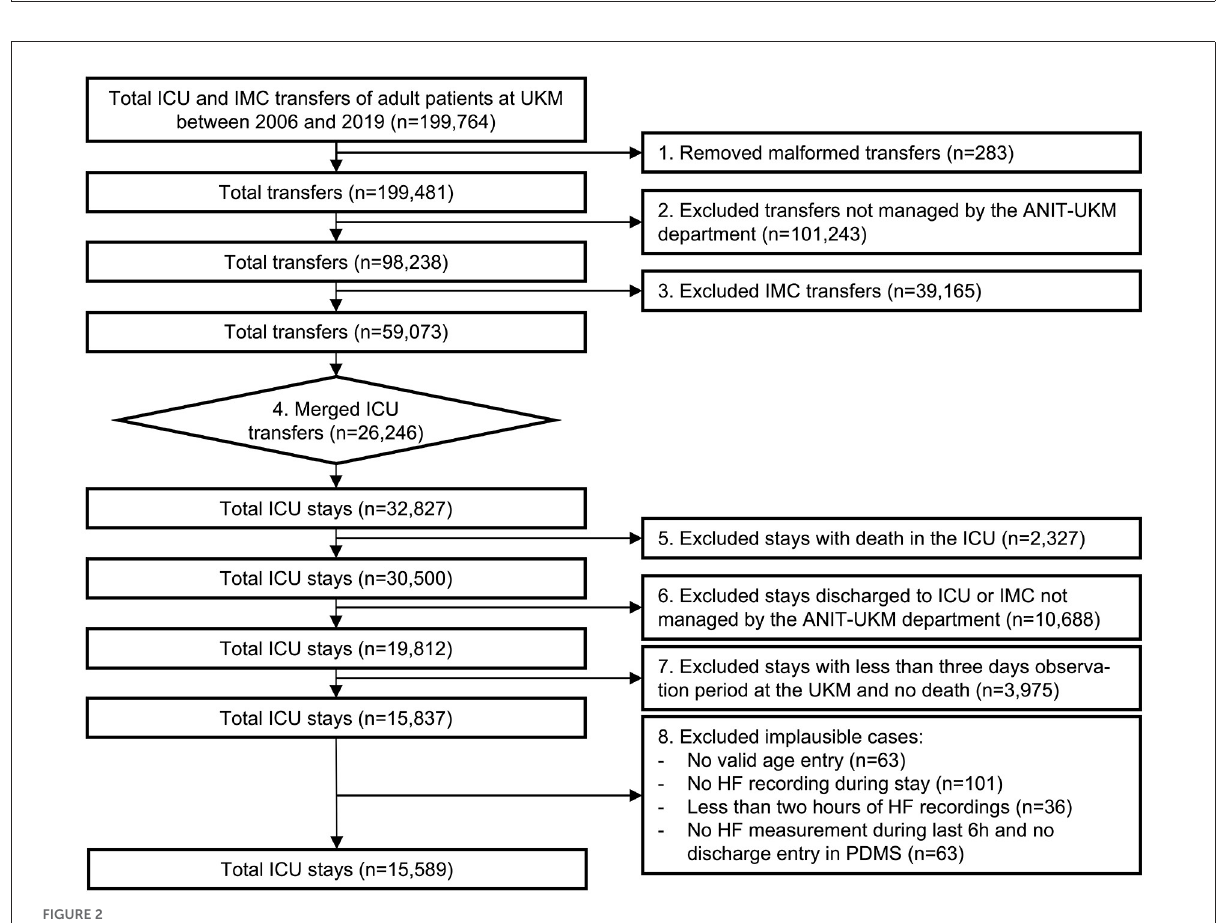
FIGURE2 Flowchart of the cohort selection for the University Hospital Münster (UKM) cohort. Transfers to ICU and IMC wards of the UKM between 2006 and 2019 served as initial data. We included four ICUs managed by the ANIT-UKM department. Transfers had to be merged using a manual procedure to obtain consecutive ICU stays. Patients who died in the ICU and those who were discharged to an external ICU or IMC were excluded. We required an observation period of at least 3 days to ensure readmission to an ICU in the UKM. Lastly, implausible cases were